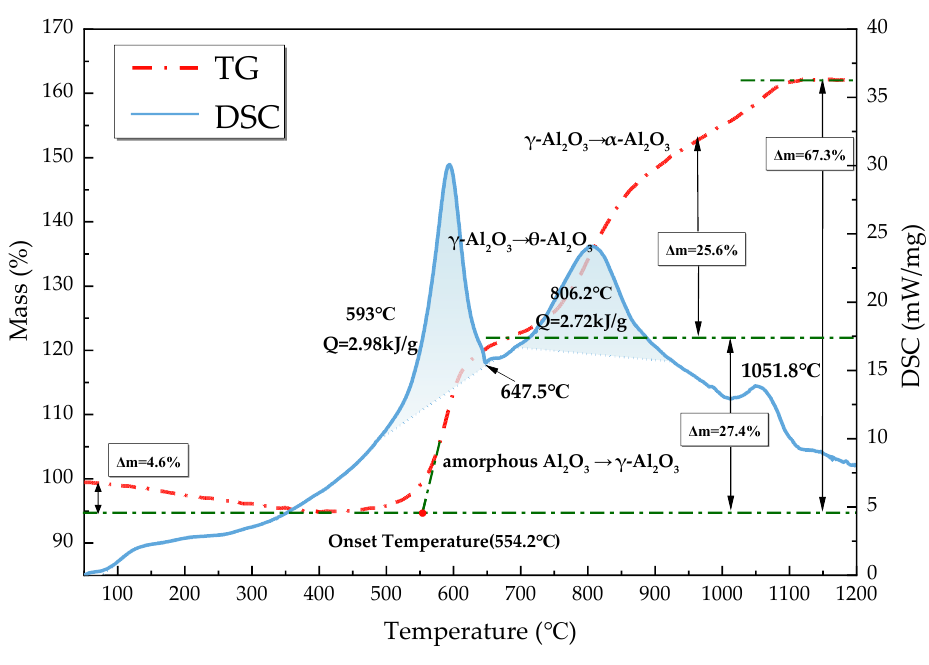
Figure 5. TG-DSC curves of C 8 H 18 -Al nanoparticles. Table 2. Thermal analysis data of three samples.